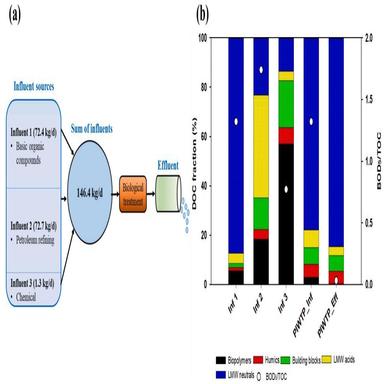
(a) Loading rates of individual groups of hydrophilic dissolved organic carbon (DOC) entering into the public industrial wastewater treatment plant (IWTP), and (b) Fractions of individual groups of DOC including biopolymers, humic substances, building blocks, low molecular weight (LMW) acids and neutrals, and biochemical oxygen demand (BOD5)/total organic carbon (TOC) ratios. "Inf" and "Eff" denote influent and effluent, respectively.